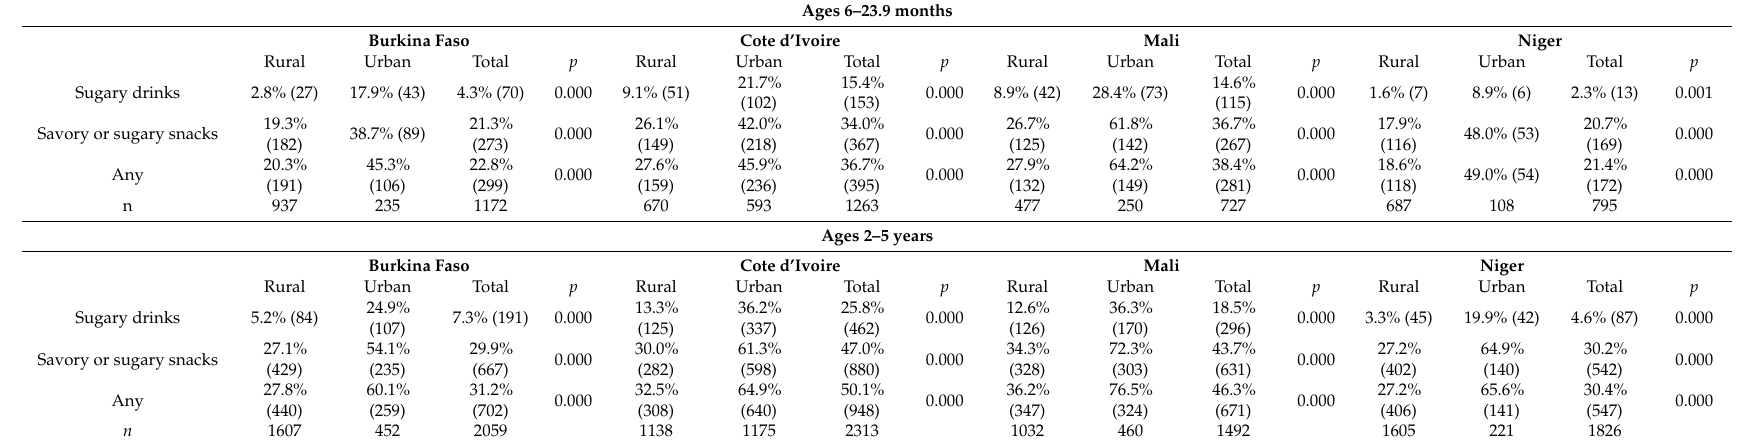
Table 3. Percentage of children consuming commercially packaged snacks in prior 24